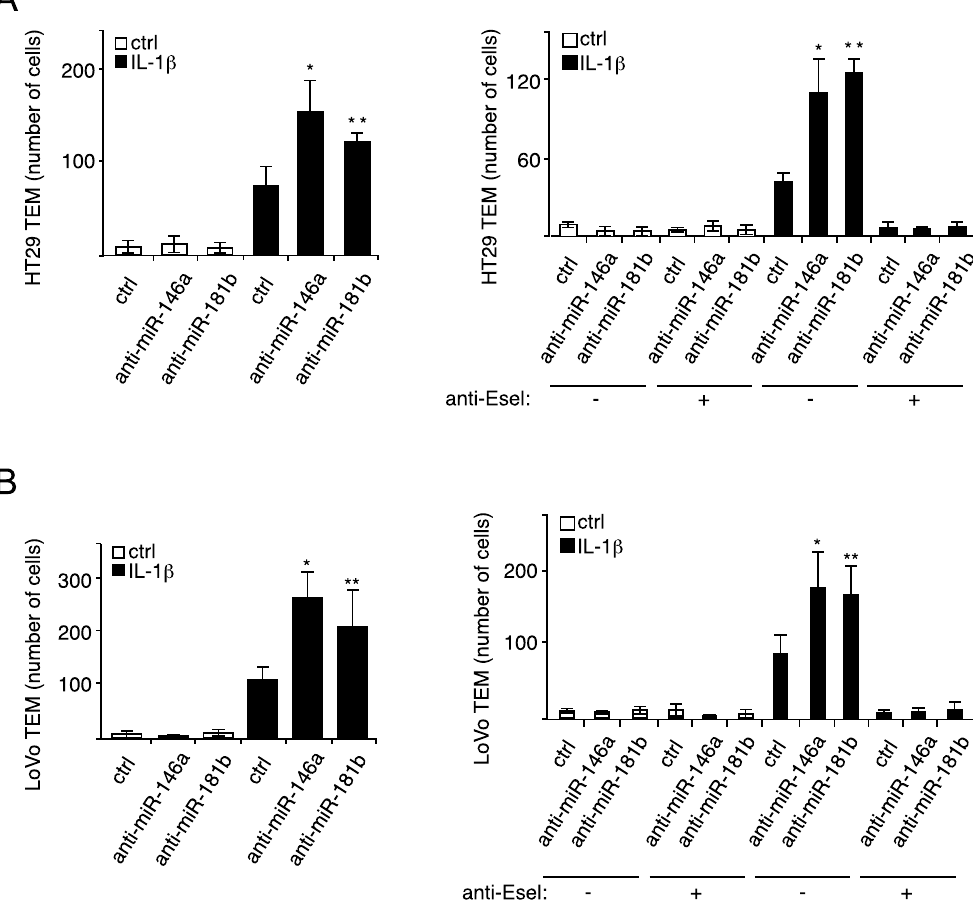
Figure 4. miR-146a and miR-181b modulate E-selectin-mediated migration of metastatic colon cancer cells through endothelial cells. ( A ) MiR-146a and miR-181b inhibit E-selectin-dependent TEM of HT29 colon cancer cells. In the Boyden Chambers, fluorescent HT29 cells that penetrated a tight layer of endothelial cells transfected with indicated miRNA inhibitors were counted. To test the E-selectin-dependence of the effect of both miRNAs on the TEM, anti-E-selectin antibody or MOPC21 antibody (1:40) was added to endothelial cells one hour before the addition of HT29 cells. Fluorescent cancer cells were counted with ImageJ with following parameters. Type: 8 bits, threshold: Otsu/dark background/12–255, analyze particle: 50-infinity. ( B ) MiR-146a and miR-181b inhibit E-selectin-dependent TEM of HT29 LoVo colon cancer cells. Experiments were carried out as described in a. Calcein AM-stained LoVo metastatic colon cancer cells were used. The quantification are the mean values of three independent experiments, the error bars represent standard errors of three independent experiments, and the significance was analyzed using a Student’s t-test. The p -values are calculated comparing to the “ anti-miR ctrl/IL- 1 β (/antibody ctrl)” group ( * p < 0.05; ** p < 0.01). Anti-Esel.: anti-E-selectin